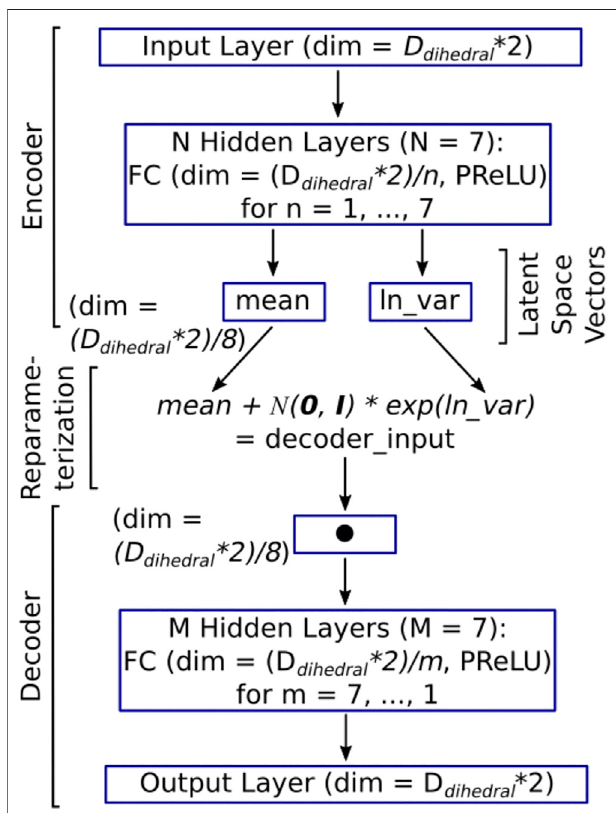
FIGURE 2 | The architecture of the DESP ’ s VAE model. The dimension of the input layer (as well as the output layer) is two times the number of dihedral angles because both the cosine and the sine of each of the dihedral angles are used to deal with periodicity issues (Mu et al., 2005). Each of the hidden layers is a fully connected (FC) layer, followed by parameterized recti fi ed linear units (PReLUs). The latent space between the encoder and the decoder has a dimension that is one-eighth of the input dimension to learn a compressed representation of the molecules in a reduced dimension. The encoder and the decoder are connected through the re-parametrization trick wherein samples are selected from the standard normal distribution, N ( 0 , I ) , and then scaled by the variance and shifted by the